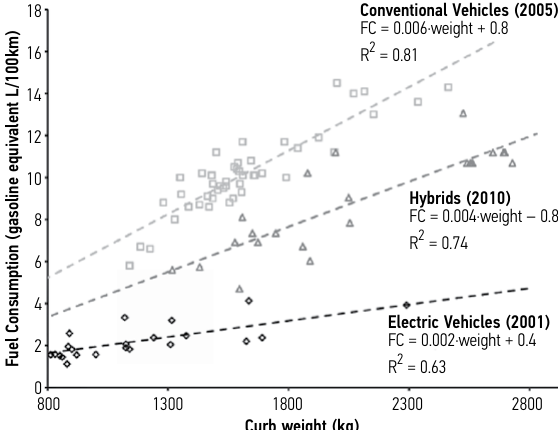
Fig. 1. Fuel use versus vehicle weight for conventional, hybrid and electric drivetrains illustrating that the more efficient a powertrain is, the less its energy use depends on weight (ADAC 2008; National Highway Traffic Safety Administration 2006; Meier-Engel